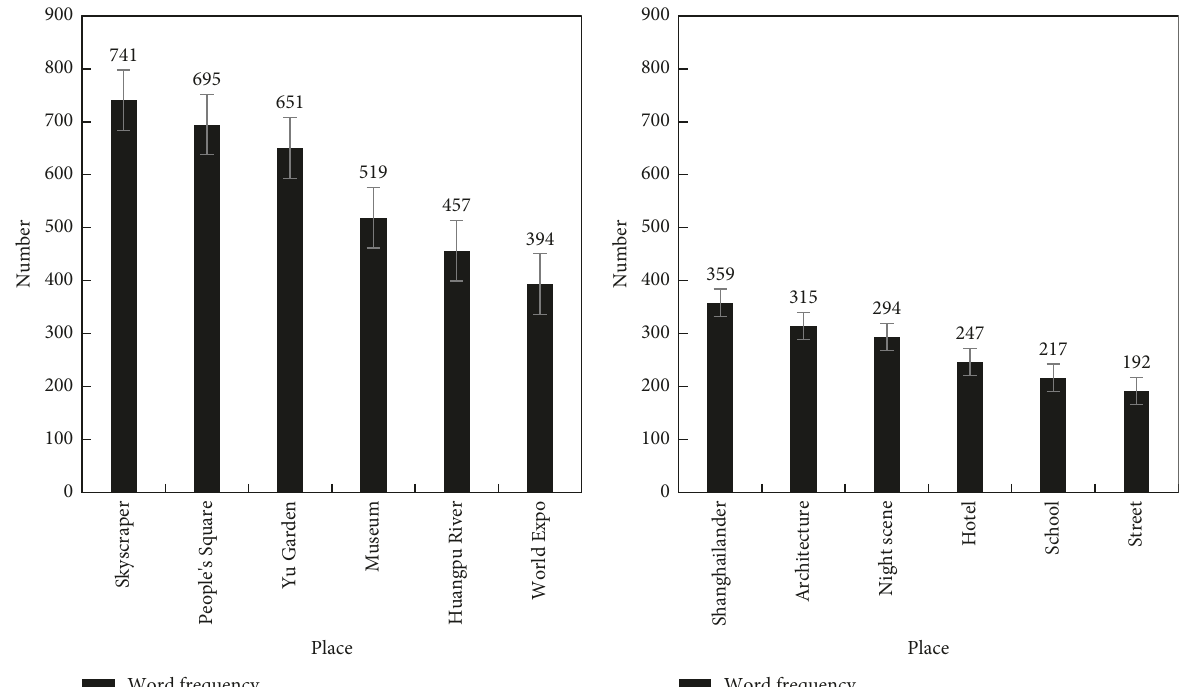
Figure 7: High-frequency words of cognitive image of Western inbound